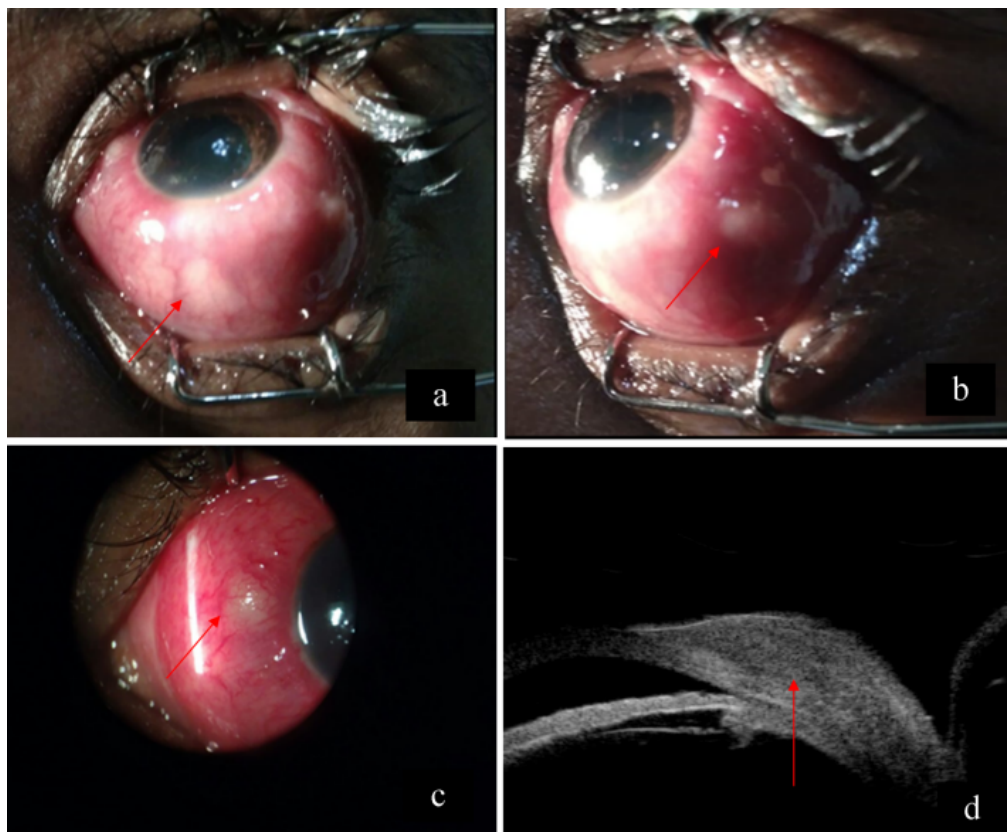
Figure 1: a–c) The left eye showing multiple scleral abscesses at presentation (arrows). d) Ultrasound biomicroscopy showing scleral thickening suggestive of scleritis with no underlying uveal tissue outpouching (arrow).